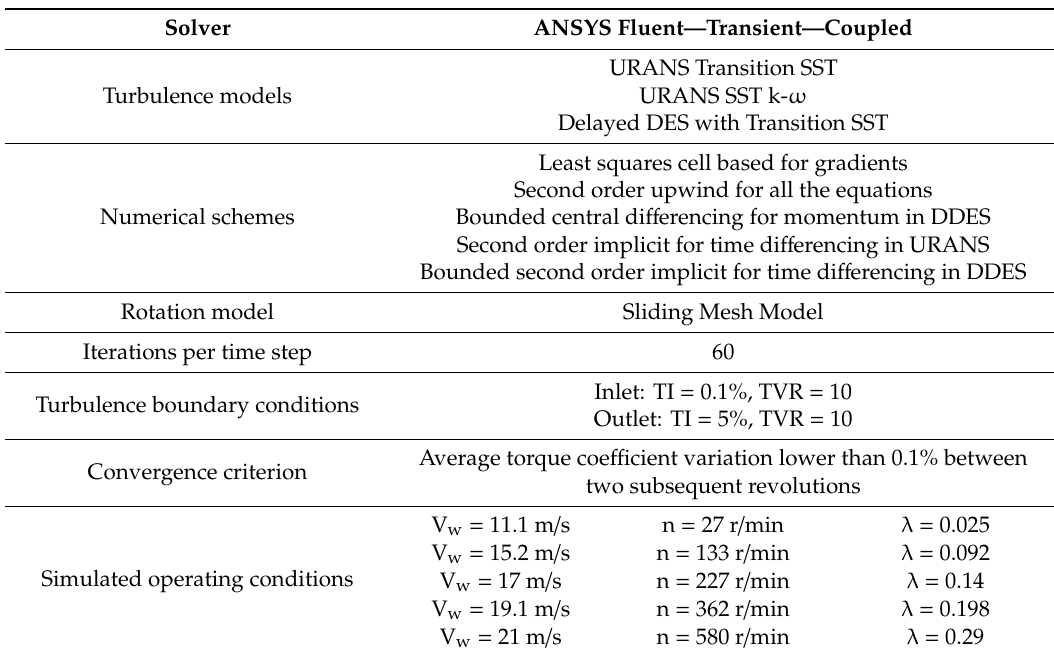
Table 4. Main CFD solver